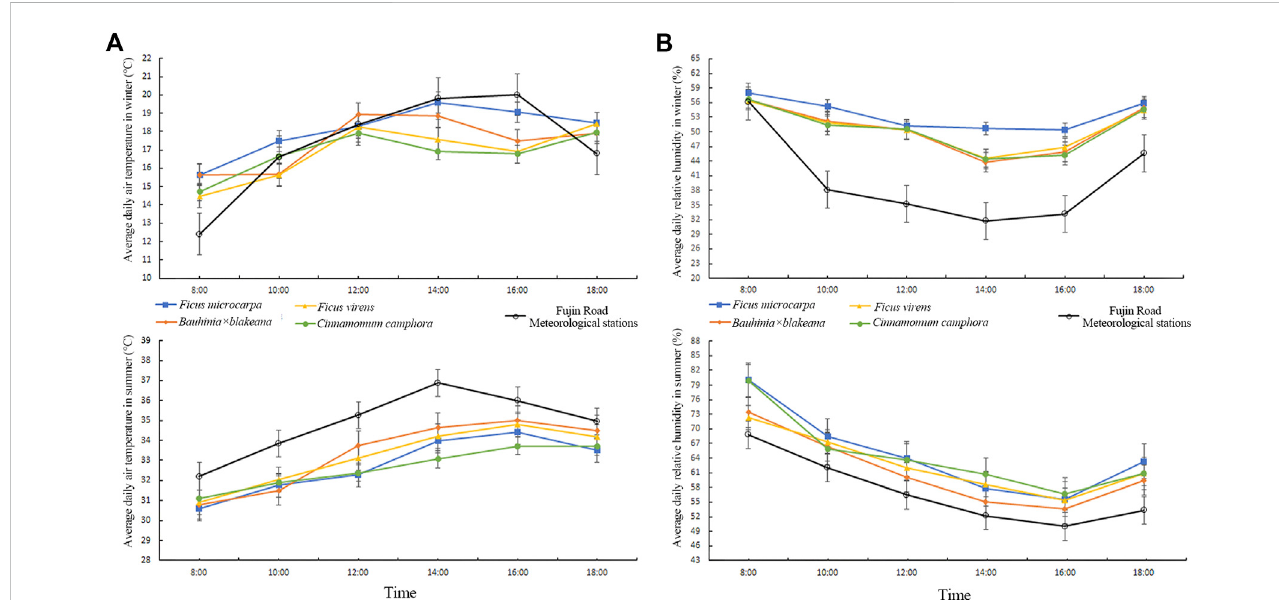
Diurnalchangeofairtemperatureandrelativehumidityofthefourtreespeciesinwinterandsummercommunityweatherstations (A) airtemperature (B) relative humidity.